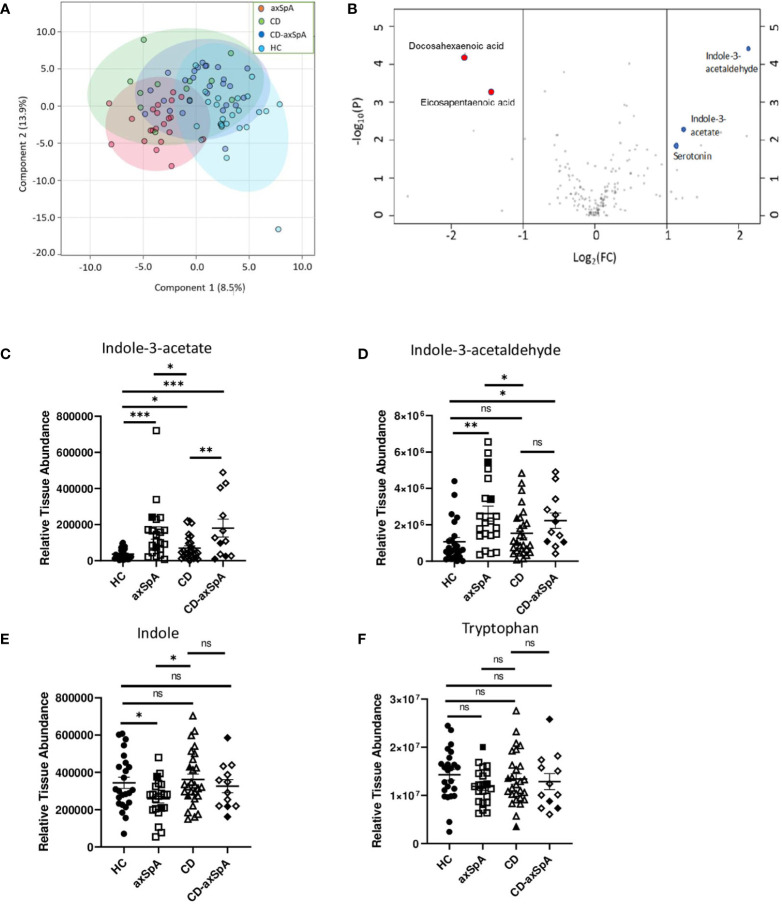
Bacteria-produced indoles are significantly increased in axSpA. Broad screening of metabolites was performed by LC-MS in colon biopsies from HC, axSpA, CD, and CD-axSpA. (A) PCoA of the metabolite data in all four groups is shown. By PERMANOVA, p<0.001. (B) Volcano plot comparing the fold change differences in metabolites (x-axis) between HC and axSpA versus p-value (y-axis). Positive fold change values indicate higher in axSpA while negative values are those higher in HC. Blue dots represent identified tryptophan derivatives of significance, and red dots represent omega-3 metabolites. Relative tissue concentrations for (C) IAA, (D) I3Ald, (E) indole, and (F) tryptophan in each subject is indicated by symbols with bars as the mean ± SEM, measures relative to one another after using the same starting tissue weight. Open symbols represent those subjects taking TNFi. *p < 0.05, **p < 0.005, ***p < 0.0005, and ns (not significant) were determined by ANOVA with Kruskal-Wallis post-hoc test.